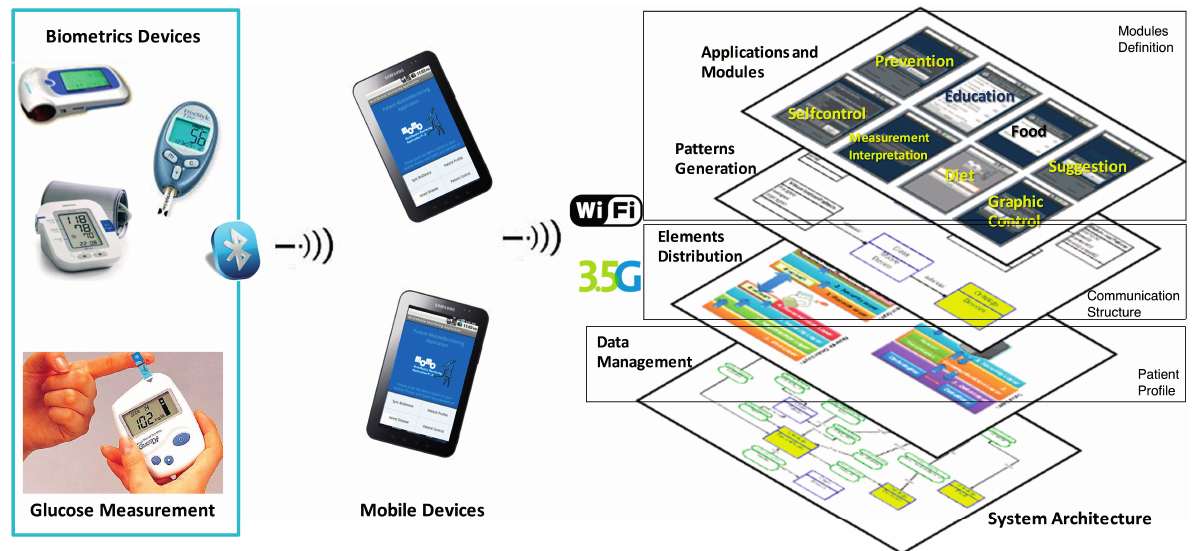
Figure 3. MoMo platform and relationship between data and device